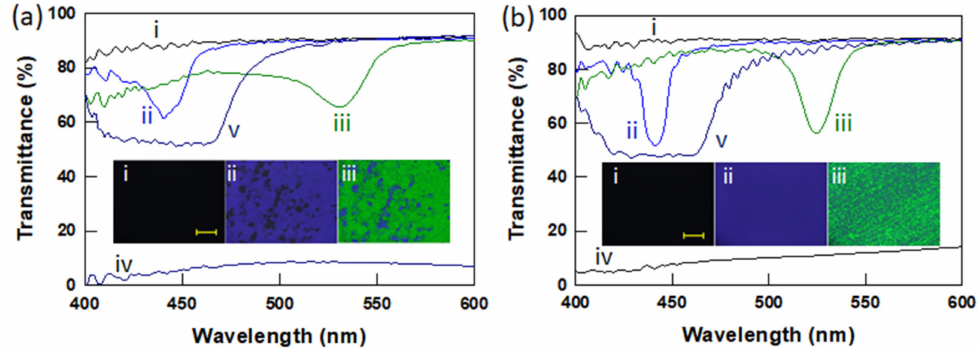
Figure 1. Transmission spectra and POM images of BPLC-0 prepared in ( a ) an unaligned cell at ( i ) 48.5 ◦ C (isotropic), ( ii ) 47.3 ◦ C (BP-II), ( iii ) 44 ◦ C (BP-I), ( iv ) 35 ◦ C (focal-conic phase), and ( v ) 24 ◦ C (CLC phase after rubbing); and ( b ) an aligned planar cell at ( i ) 49 ◦ C (isotropic), ( ii ) 47.8 ◦ C (BP-II), ( iii ) 46.5 ◦ C (BP-I), ( iv ) 35 ◦ C (focal-conic phase), and ( v ) 24 ◦ C (CLC phase after rubbing).